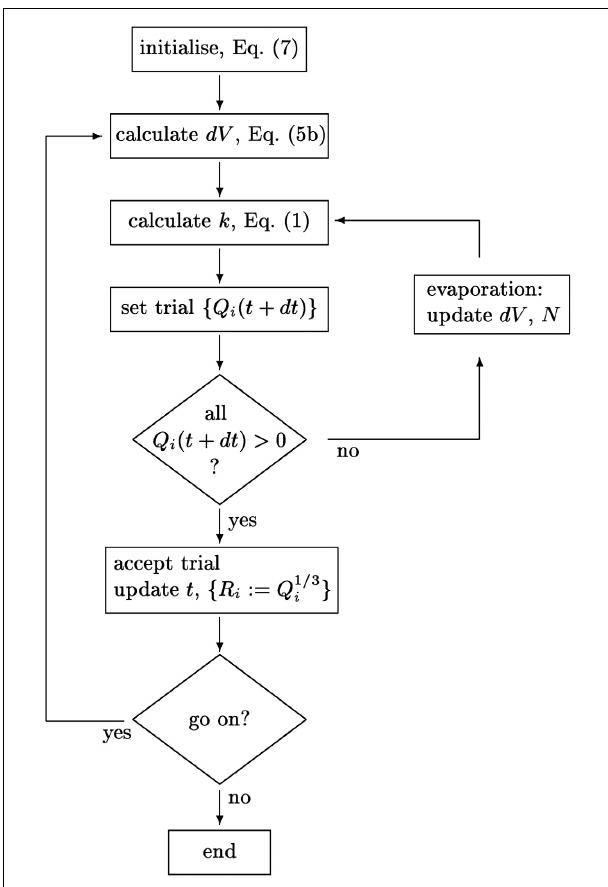
FIGURE 2 | Schematics of the integration scheme for the size distribution { R i } i = 1 ... N . The aggregate number N , the volume increments d V and the parameter k are self-consistently adjusted when small aggregates